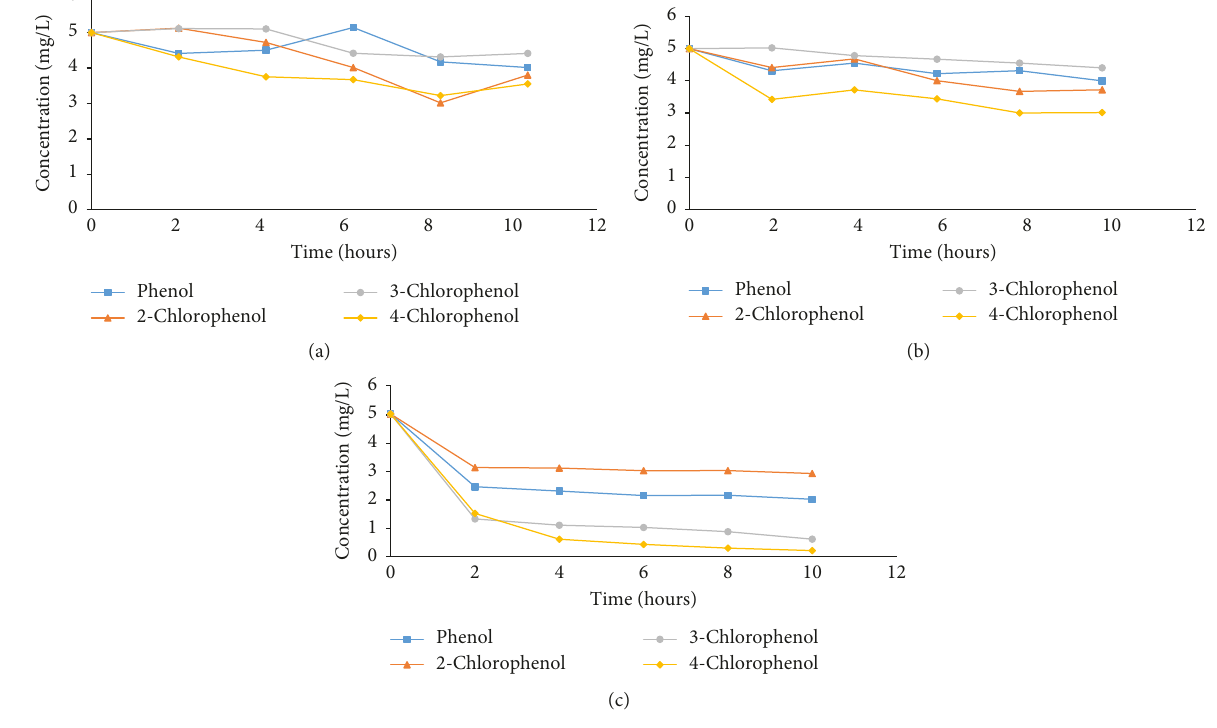
Figure 4: Time-dependent adsorption kinetics of phenols on the clay samples. (a) E1, (b) E2, and (c) C1.